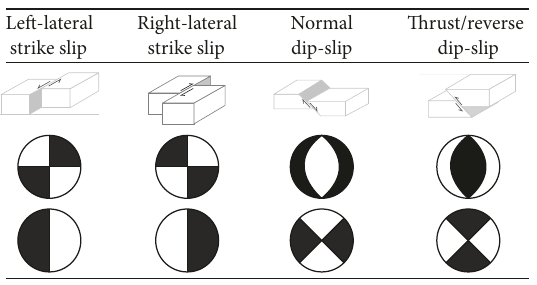
Figure 2: Fault types with corresponding beach ball plots seen in map view as shown in upper row and side view as shown in lower